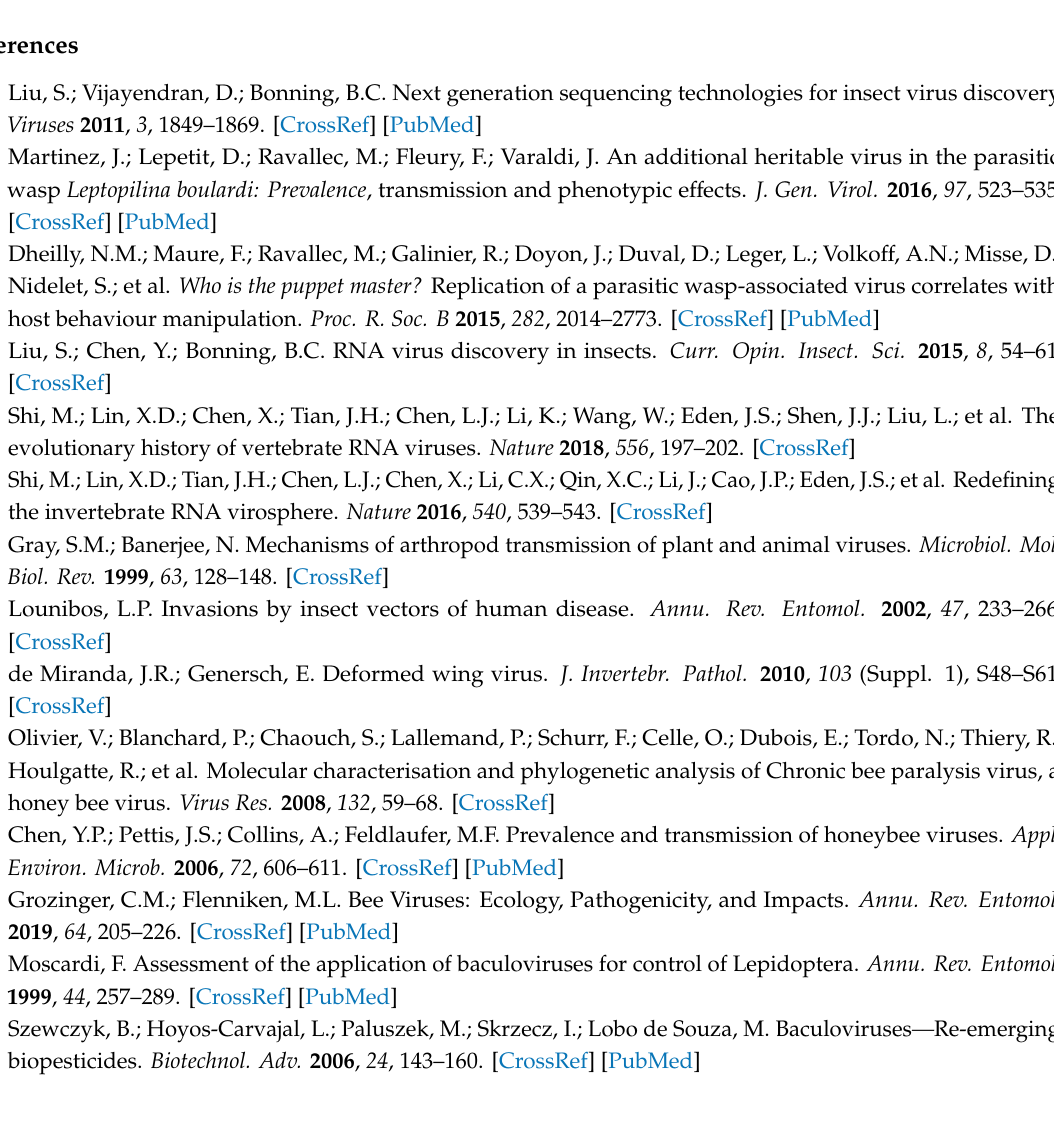
showing that frequencies of infection were unequal among parasitoid lines. Table S5: Mixed models testing for di ff erences of viral infection intensity as estimated from qPCR, comparing either individuals of lab populations (top half) or ovary dissected samples of lab populations (bottom half). Table S6: Mixed model comparing either generation 3 individuals of pools with detected horizontal transmission, based on qPCR values (top), infected H76 individuals of all three generations for vertical transmission (middle) or H76 individuals with vertical transmission across two generations